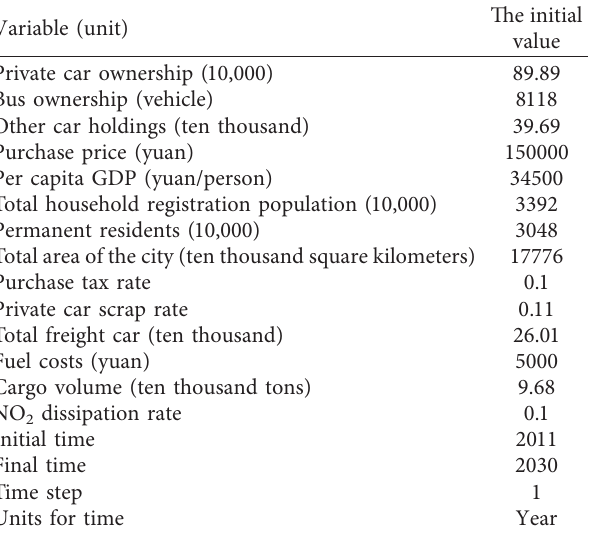
Table 3: Initial values of the